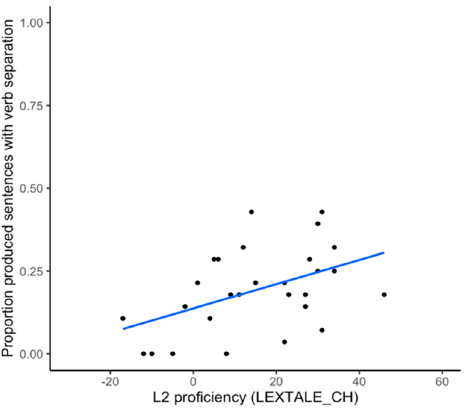
Figure 6. Rate of correctly produced sentences with verb separation across L2 proficiency.